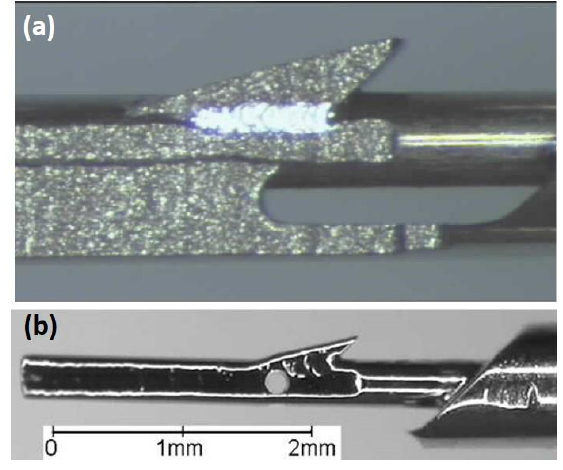
Figure 35. A miniature glaucoma implant (Ex- PRESS™, Optonol Ltd.) made of 316LVM steel. ( a ) A close-up after mechanical grinding, and ( b ) A device after novel electropolishing [369]. Reprinted with permission of John Wiley and Sons.